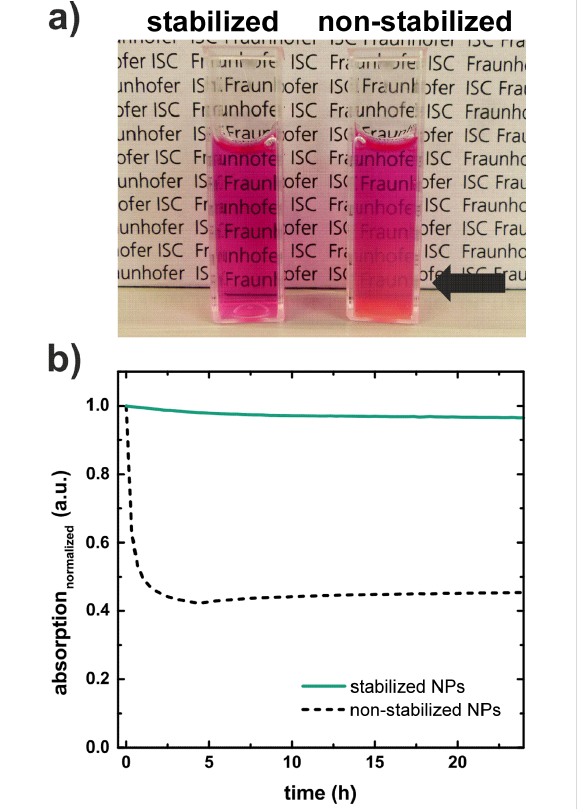
Figure 6: Sedimentation study of the CaF 2 :(Tb 3+ ,Gd 3+ ) NPs (5 mg·mL − 1 ) in Dulbecco’s Modified Eagle’s Medium (DMEM) with 10% FCS stabilized with Melpers ® 2450 and non-stabilized: a) photographs of the stabilized NPs and the non-stabilized NPs 24 h after dispersing the NPs in FCS-containing cell-culture medium and b) absorbance measurement ( λ abs = 700 nm) of the samples over a period of 24